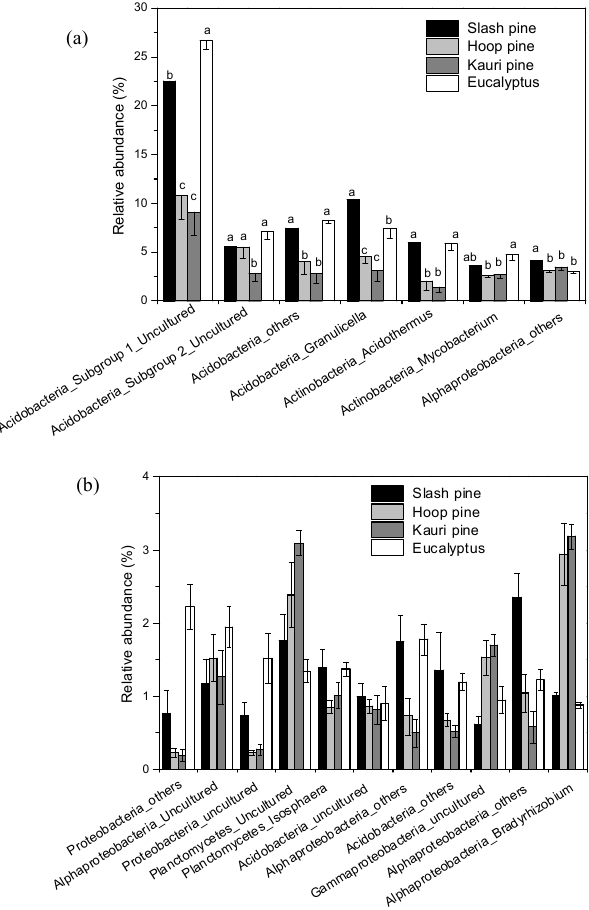
Figure 2. Most abundant bacterial genera in soils under different tree